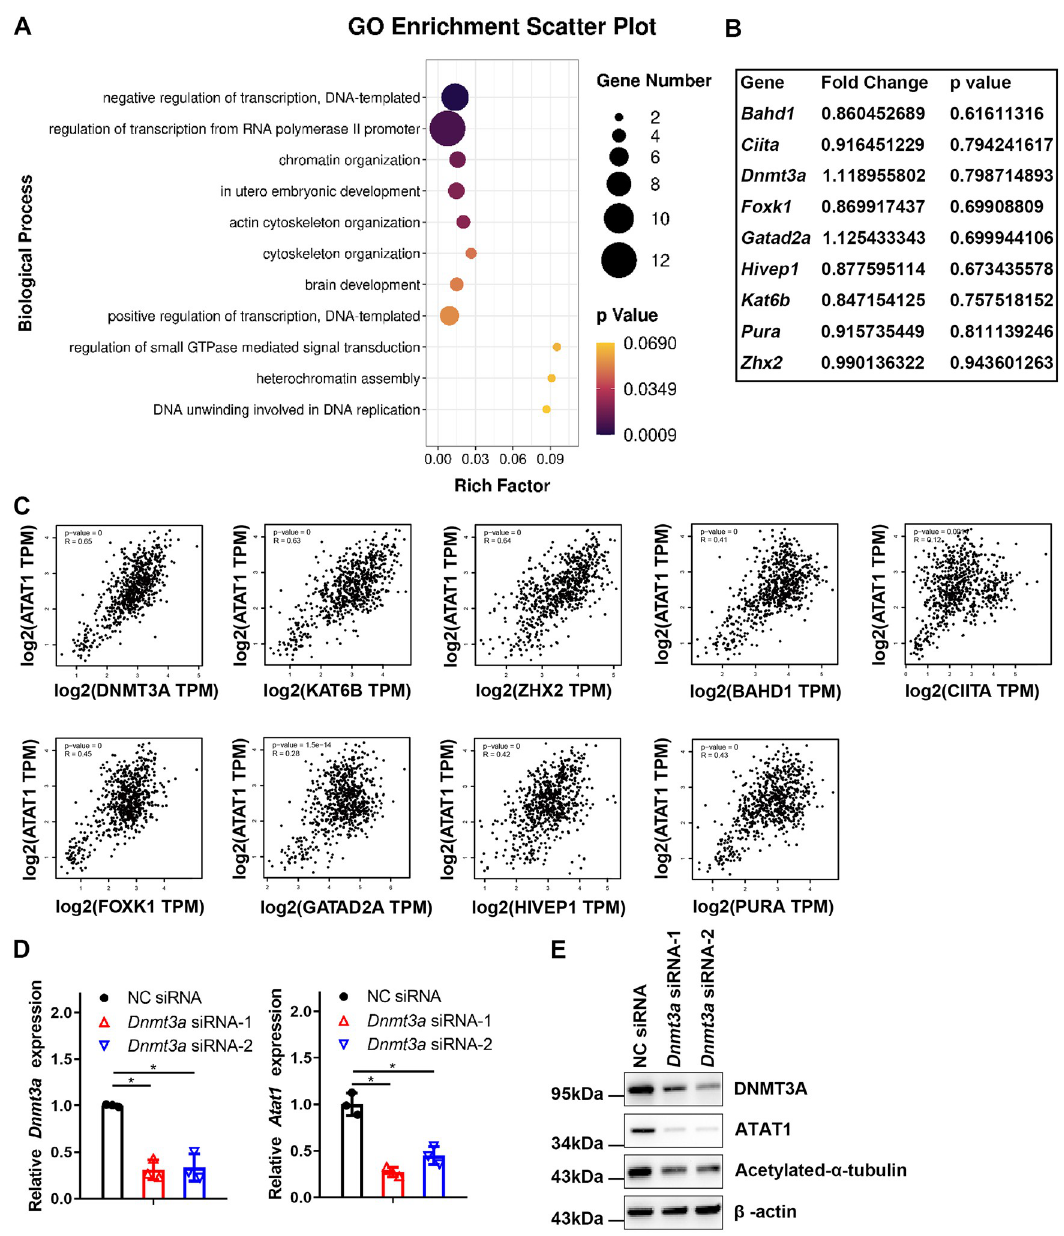
Fig 3. DNMT3A is a target gene of METTL3 and maintains ATAT1 expression. (A) GO enrichment analysis (biological process) of m6A down-regulated genes in BMDMs. (B) The expression of the indicated genes in KO BMDMs compared with WT BMDMs. (C) The association between the expression of the indicated genes and ATAT1 expression was analyzed in normal tissue through the GEPIA database. (D) The expression of Atat1 was measured by qRT-PCR in WT BMDMs with Dnmt3a knockdown. (E) Immunoblotting analysis of the indicated proteins in the BMDMs transfected with NC siRNA or Dnmt3a siRNA. All data in the figure are shown as the mean ± SD. P < 0.05 ( � ). NS indicates no significant difference. Underlying data can be found in S1 Data. BMDM, bone marrow-derived macrophage; KO, knockout; NC, negative control; qRT-PCR, quantitative reverse transcription PCR; WT, wild type.